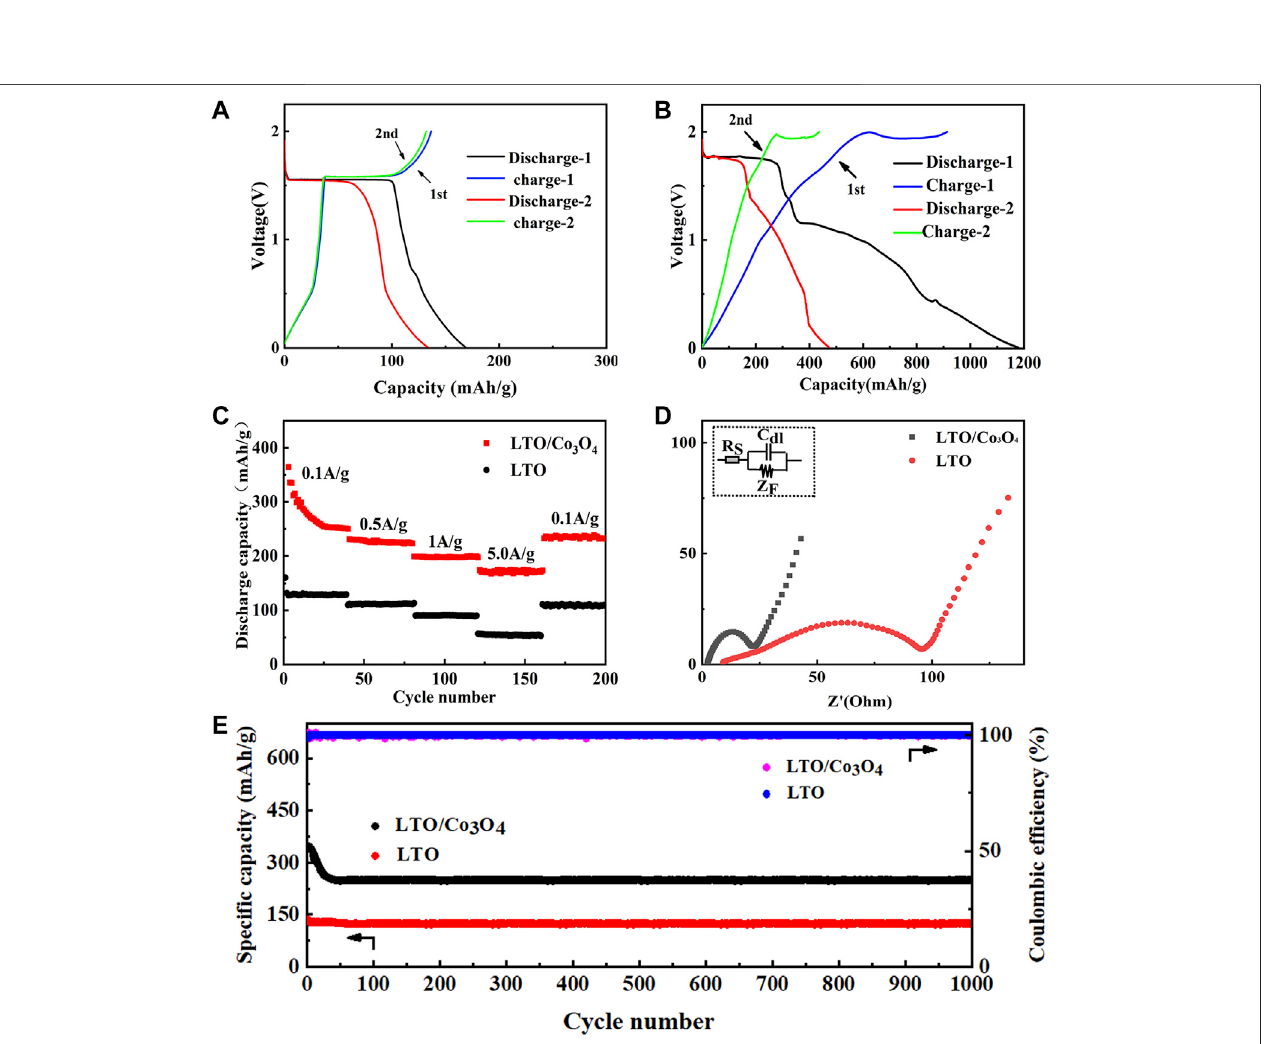
FIGURE 4 | (A) The fi rst and second charge/discharge curves of Li 4 Ti 5 O 12 . (B) The fi rst and second charge/discharge curves of Li 4 Ti 5 O 12 /Co 3 O 4 . (C) The rate performance comparison of Li 4 Ti 5 O 12 and Li 4 Ti 5 O 12 /Co 3 O 4 . (D) The EIS (AC impedance) diagram of Li 4 Ti 5 O 12 and Li 4 Ti 5 O 12 /Co 3 O 4 . (E) Cycle performance curves comparison of Li 4 Ti 5 O 12 and Li 4 Ti 5 O 12 /Co 3 O 4 at